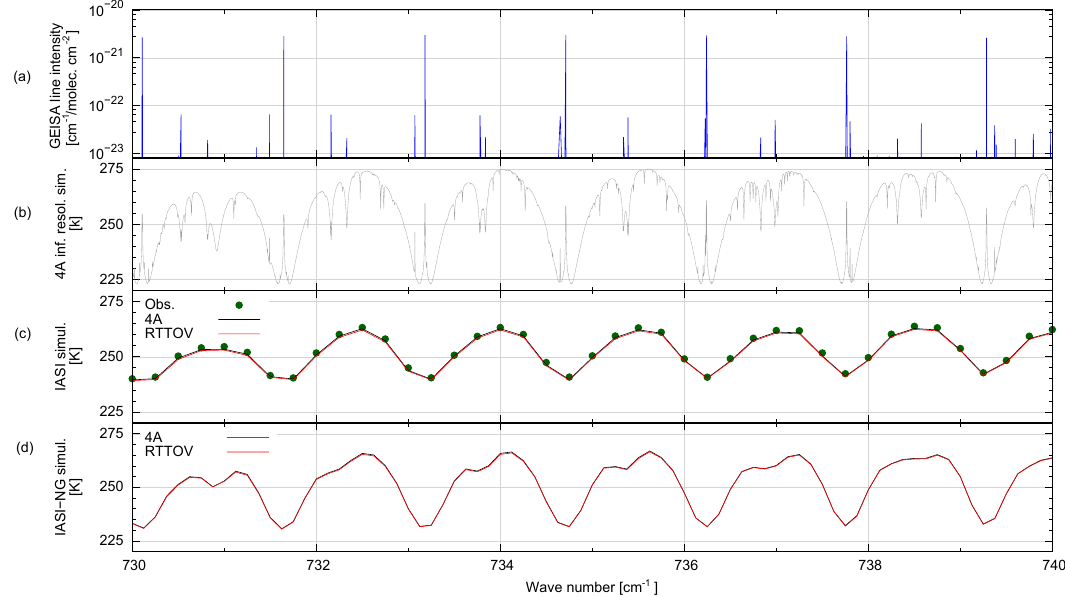
Figure 6. Comparison of IASI/IASI-NG brightness temperature simulations in the 730–740cm − 1 CO 2 absorption window against the Earth IR spectrum computed by 4A using a spectral resolution of 0.001 cm − 1 for one atmospheric description included in the simulation dataset. (a) presents the CO 2 absorption lines as obtained from the GEISA database; (b) shows the 4A spectrum calculation. (c) and (d) present the simulations of IASI and IASI-NG spectra respectively. IASI observations are also included in the IASI simulations panel (green dots).